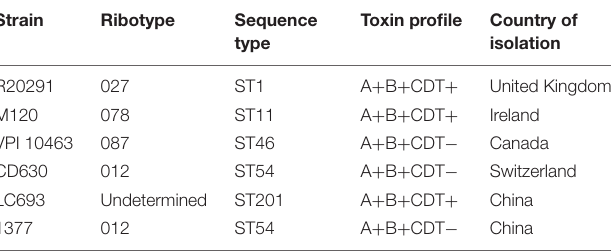
TABLE 1 | Information of Clostridioides difficile strains used in this